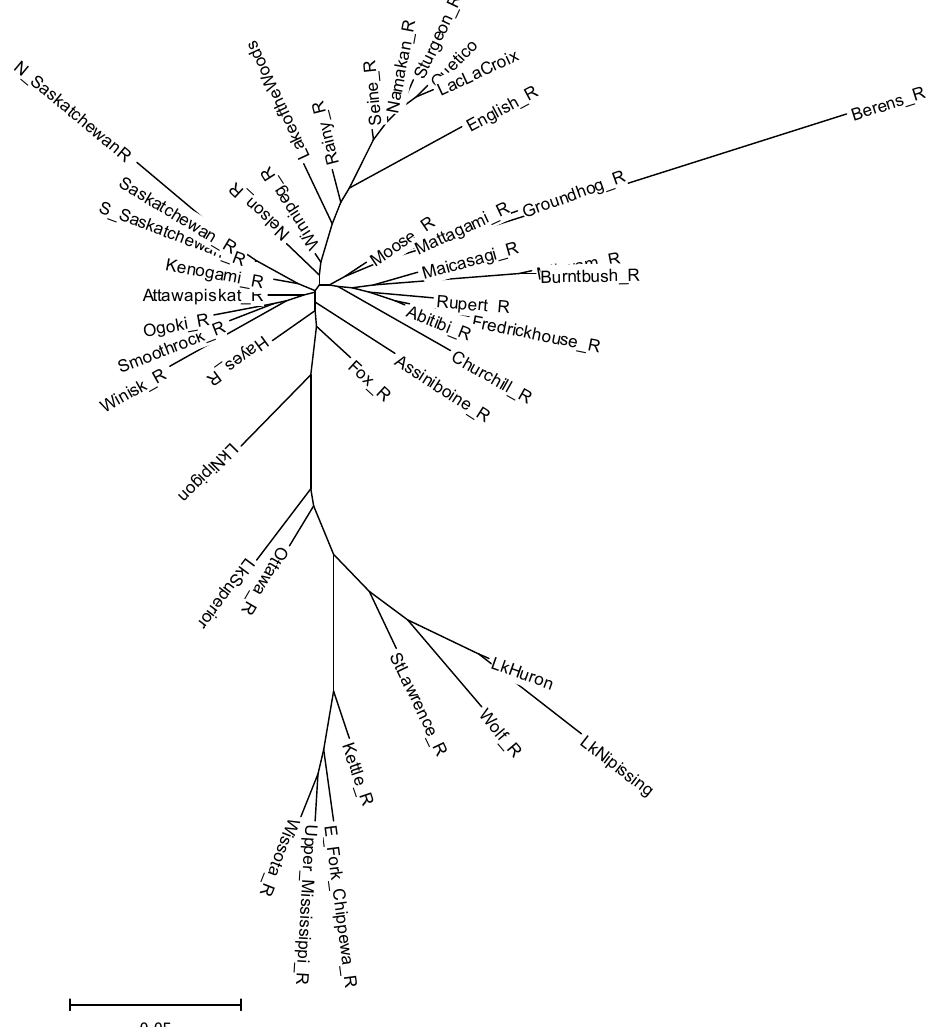
Figure 4. Unrooted neighbor-joining dendrogram of genetic relationships among sampled populations of lake sturgeon based on Nei et al.’s (1983) genetic distance ( D a ). Populations with fewer than 10 samples were excluded to avoid sample-size artefacts in estimating genetic distance.